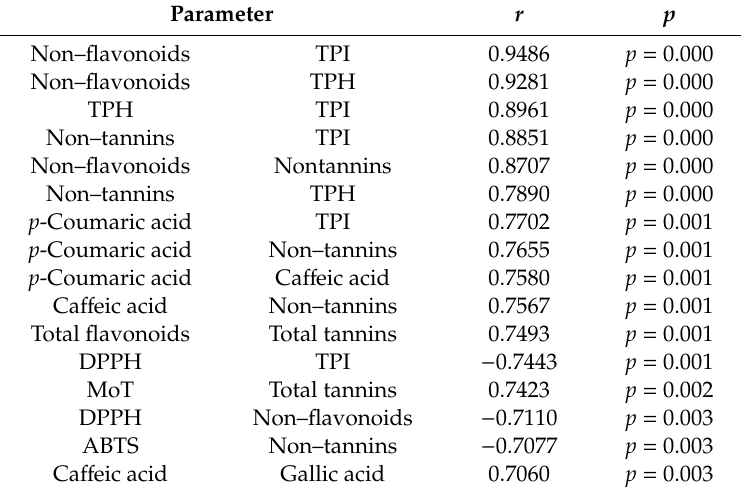
Table 3. Statistically significant correlations ( p < 0.01) between the analyzed parameters and compounds of blackberry